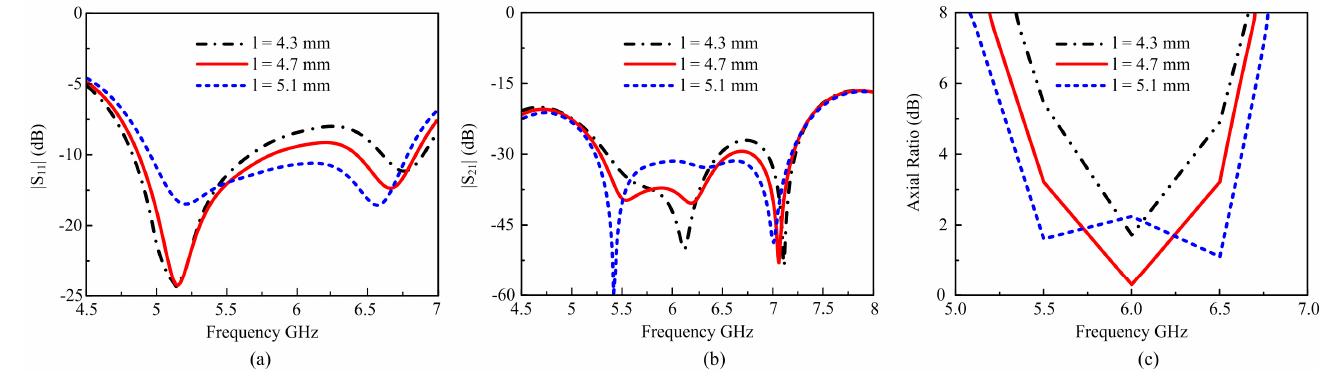
Figure 7. Simulated results for the antennas with different square cuts of l: ( a ) |S 11 |; ( b ) |S 21 | ( c ) Axial ratio.